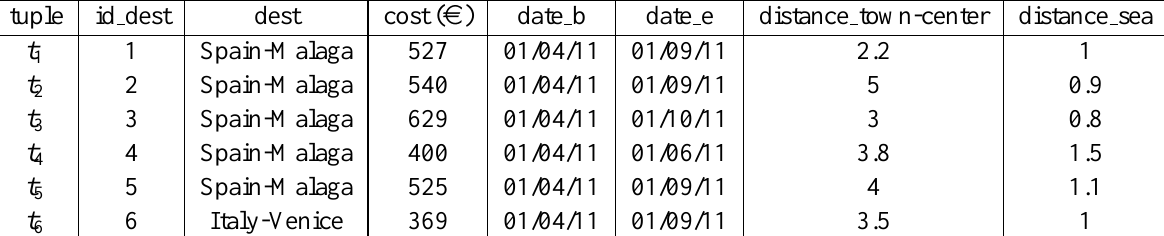
Table 1: An instance of travAg